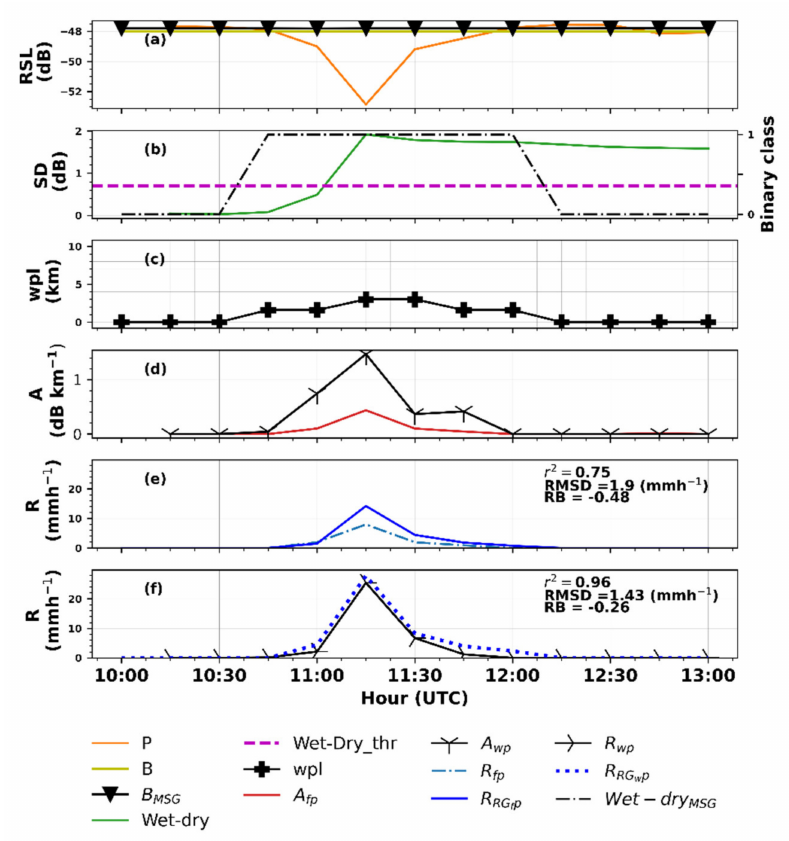
Figure 4. ( a – f ) As in Figure 3 but for 15 min interval rain events of 2 June